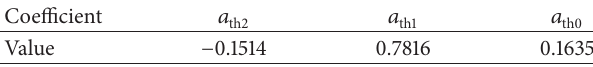
Table 5: Coefficient values of the effective opening area.